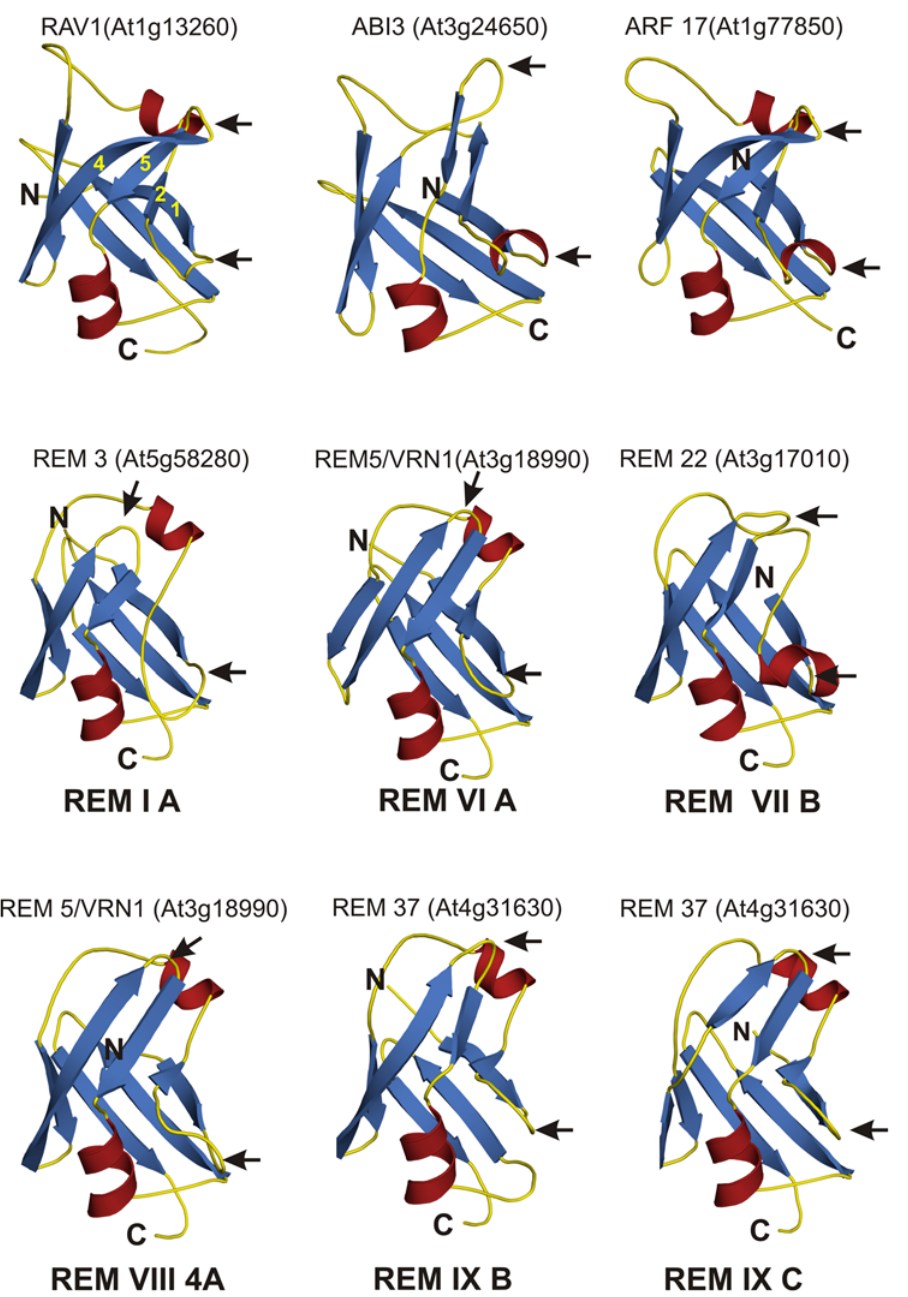
Figure 8. B3 domain modelling of RAV1, ABI3, ARF17 and six distinct REM domain types (REM3, VRN1/REM5, REM22 and REM37). These proteins belong to different B3 families and contain most of the types of B3 domains identified by our phylogenetic analysis. The NMR solution structures for the Arabidopsis protein REM14 (residues 1 to 102; PDB ID 1YEL) or RAV1 (residues 182 to 295; PDB ID 1WID) were used as template. The REM proteins evaluated contain identical structure to RAV1, although they present poor sequence conservation in the two loops (between b strand 1 and 2 and between b strand 4 and 5) that are proposed, in the model, to interact with the DNA (arrows). In addition, the loops are also shorter when compared with member of RAV, ARF, ABI3 and HSI families.